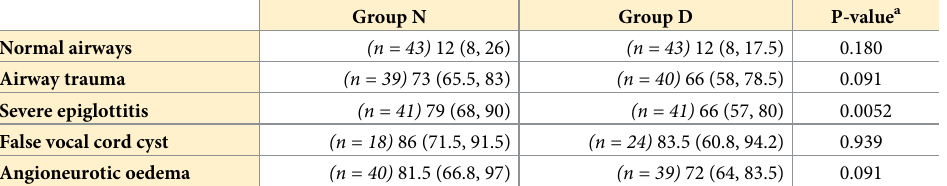
Table 5. Comparison of perceived level of difficulty for each scenario according to groups during final testing (Visual Analogic scale (VAS) from 0 to 100). Group